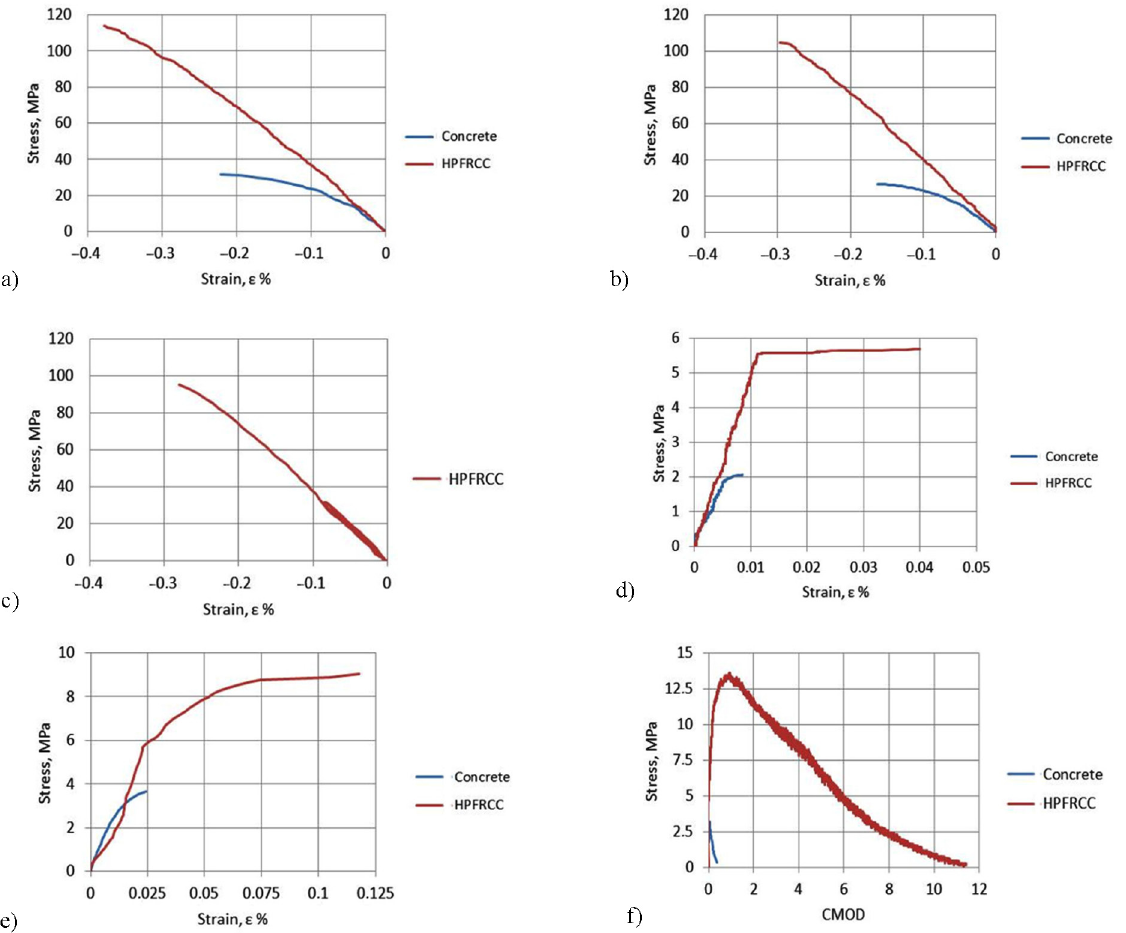
Fig. 5. Stress-strain and stress-deflection curves: (a) stress-strain curves of cylinder samples, (b) stress-strain curves of prismatic samples, (c) stress-strain curve of prismatic (40×40×160) sample, (d) stress-strain curves of tensioned prismatic (100×100) samples, (e) stress-strain curves derived from flexural test of prismatic (100×100×400) samples, (f) stress-deflection curves of prismatic (150×150×600) samples